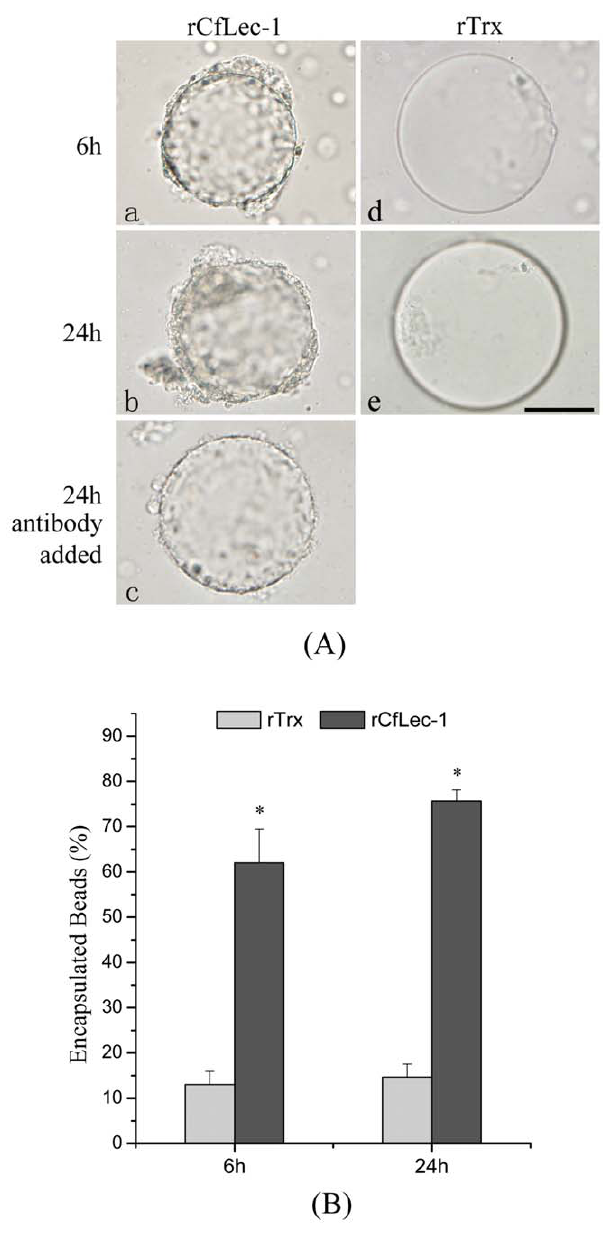
Figure 5. rCfLec-1 promotes encapsulation by scallop hemo- cytes. Nickel agarose beads coated with rCfLec-1, or rTrx were incubated with scallop hemocytes. Encapsulation of the protein-coated beads was observed by microscopy after 6 and 24 h incubation. rCfLec- 1-coated agarose beads were pre-incubated with antibody of rCfLec-1, and encapsulation of the antibody-bound beads was performed as above and observed. (A) Protein-coated beads were encapsulated by scallop hemocytes, and hemocyte encapsulation of the lectin-coated beads was block by antiserum specific for rCfLec-1, bar=50 m m. (B) The numbers of encapsulated at 6 h and 24 h beads. The columns represent the mean of three individual counts 6 S. E. M.